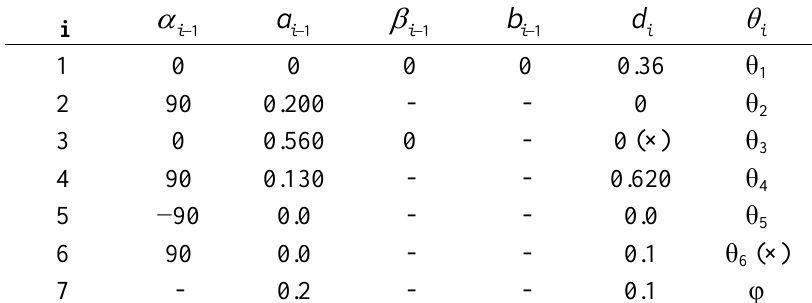
Table 3. D-H parameters of robot HA-06 (units: length [m], angle: [deg]; - : not exist, × : not